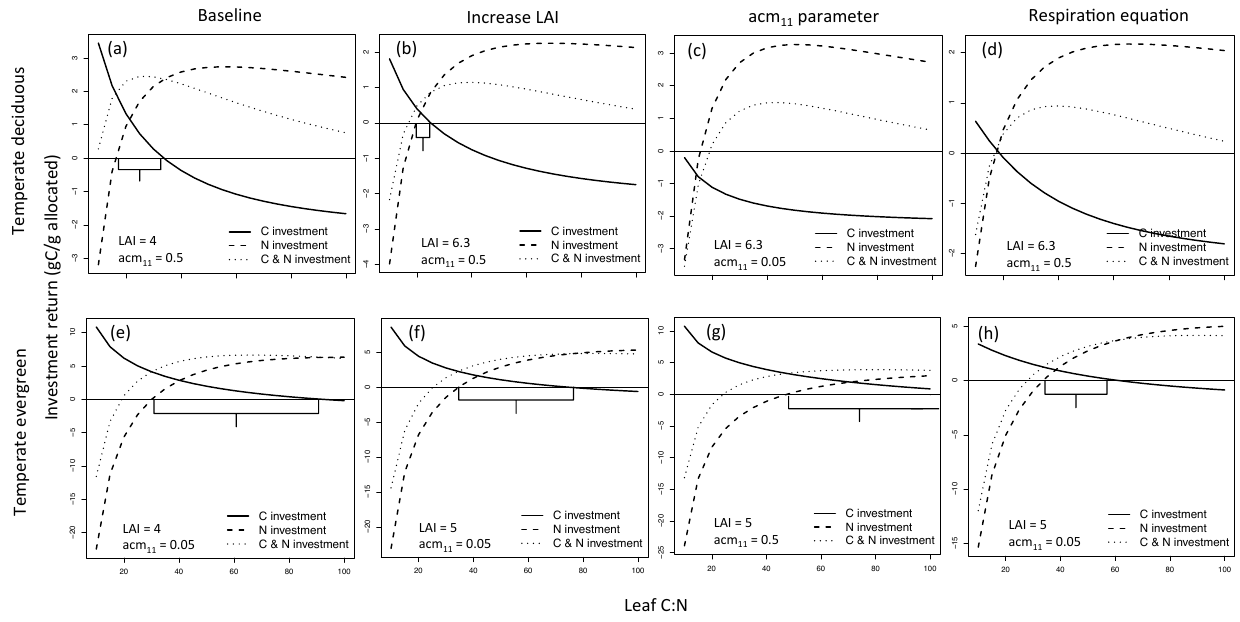
Figure 4. Sensitivity of the range of leaf C:N with positive C returns on marginal investment of leaf C and leaf N for a temperate deciduous (a–d) and an evergreen (e–h) forest. The range of leaf C : N with positive returns increases with leaf area index ( a vs. b ; e vs. f ) and depends on the acm11 parameter ( a vs. c ; e vs. g ), and the non-linearity of the leaf respiration parameterization ( a vs. d ; e vs. h ). (a and e) use the log–log relationship between N concentration and leaf respiration from Reich et al. (2008) and ( d and h ) use the linear relationship from Ryan (1991). Brackets indicate range of leaf C:N where leaf C:N can vary based on N status of the plant.